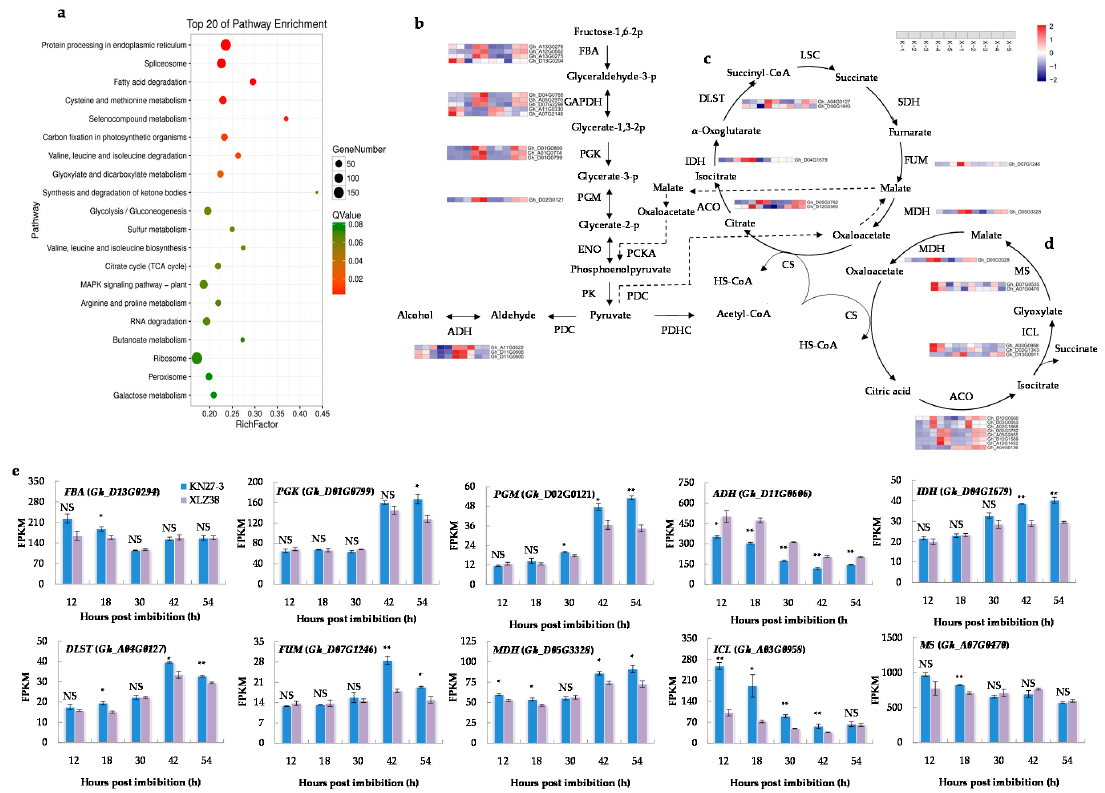
Figure 3. Kyoto Encyclopedia of Genes and Genomes (KEGG) pathway enrichment analysis of DEGs. ( a ) The top 20 enriched pathways. The colors are shaded according to the Q-values level, as shown in the color bars gradually from low (red) to high (green); the size of the circle indicates the number of DEGs from small (less) to big (more); ( b ) glycolysis / gluconeogenesis pathways connected by black straight arrow line / black dashed arrow line and tricarboxylic acid (TCA) cycle ( c ) and glyoxylate cycle (GAC) metabolism ( d ) shown by the loop diagram. Relative levels of DEG expression are shown by a color gradient from low (blue) to high (red); ( e ) fragments per kilobase of transcripts per million mapped fragments (FPKM) of di ff erent major genes involved in the above metabolic pathways at di ff erent hours post imbibition. K, KN27-3. X, XLZ38. The numbers along the X-axis represent the sampling hours post imbibitions. The numbers in the scale bars indicate the log2 (fold changes) in gene expression. Bars marked with asterisks indicate di ff erences change between the same hour (* p < 0.05, ** p < 0.01) according to Duncan’s multiple range test using SPSS software. “NS” represents no difference.